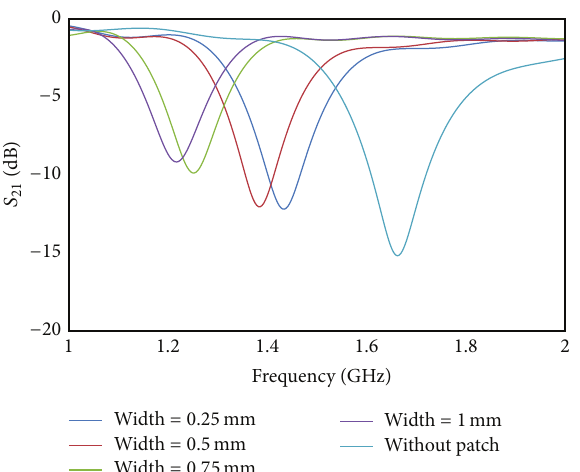
Figure 3: Simulated 𝑆 21 with different width of conducting patch.